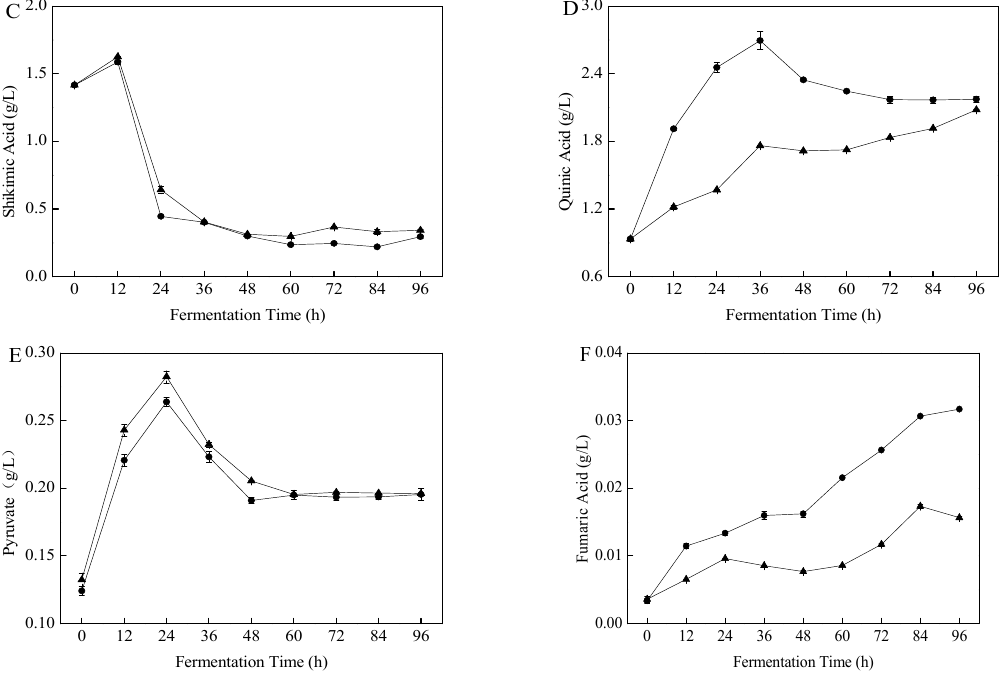
Figure 3. The content of malic acid ( A ), citric acid ( B ), quinic acid ( C ), shikimic acid ( D ), pyruvate ( E ), and fumaric acid ( F ) in S. cerevisiae SC125-fermented ( • ) and control ( (cid:78) ) beverages during the fermentation process.